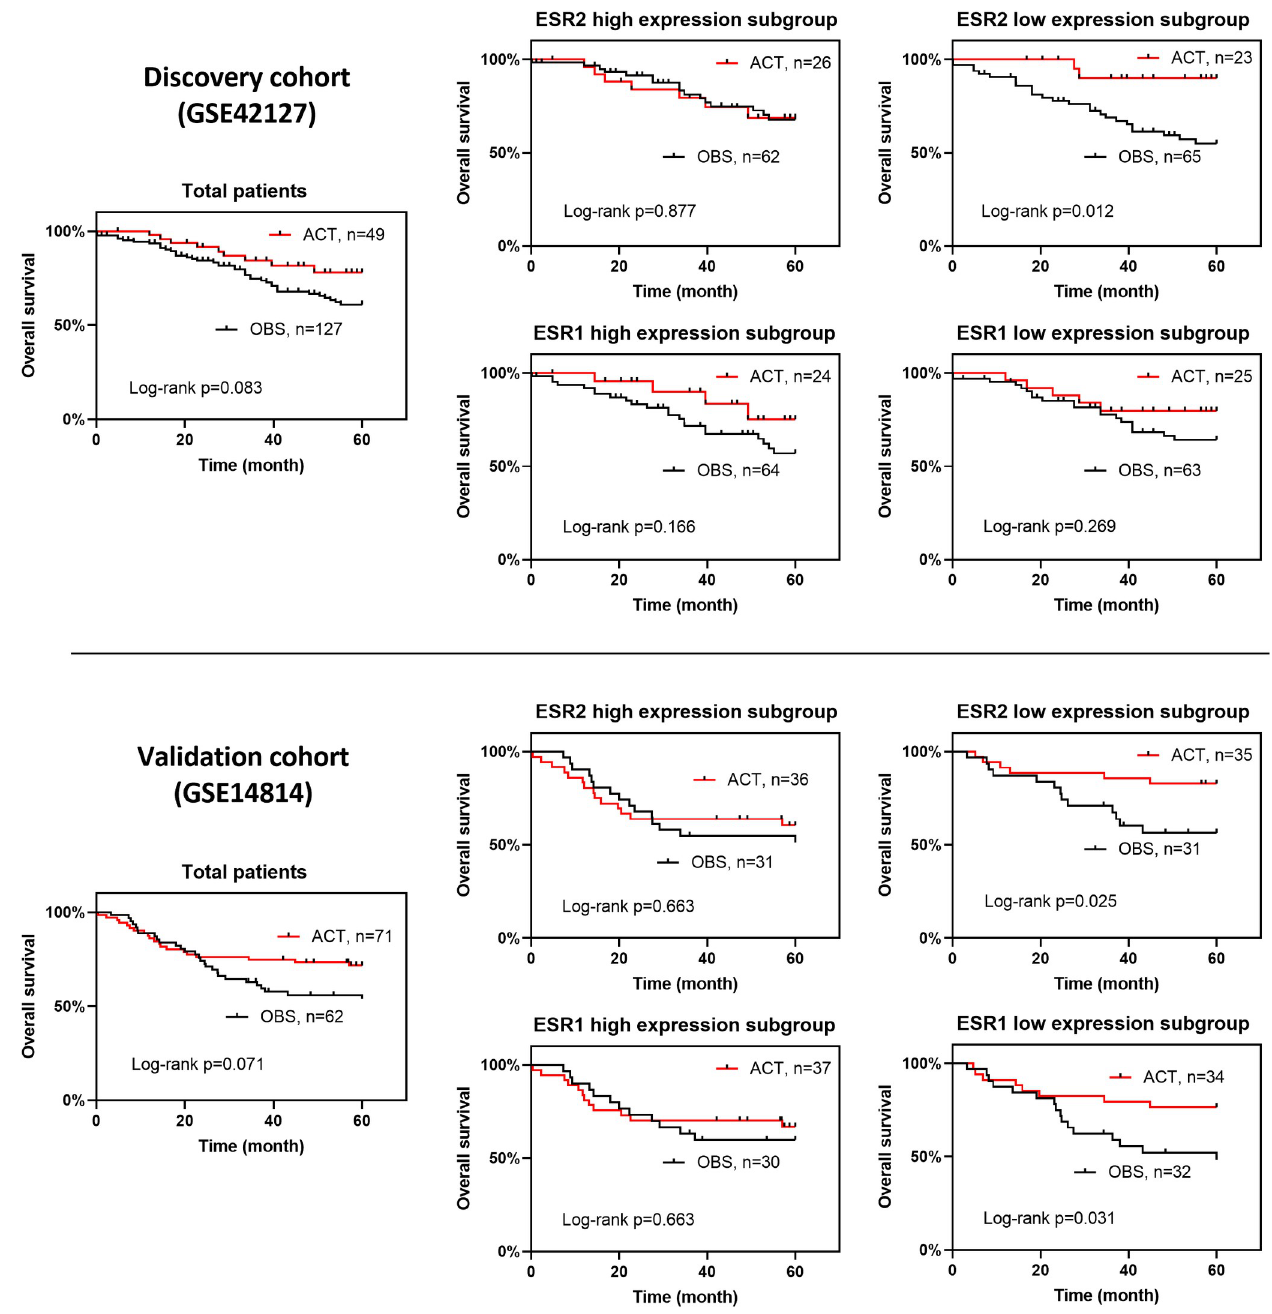
Fig 1. Kaplan–Meier estimates of the 5-year OS according to treatments in patients with high and low expression of ESR1 and ESR2. A consistent survival benefit of ACT in patients with low ESR2 expression after resection of NSCLC was observed in both discovery and validation sets, but the same result was not observed for ESR1. In patients with high expression of ER, regardless of ESR1 or ESR2, no survival benefit was noted in both discovery and validation sets. A, Kaplan–Meier plots of the discovery set; B, Kaplan–Meier plots of the validation